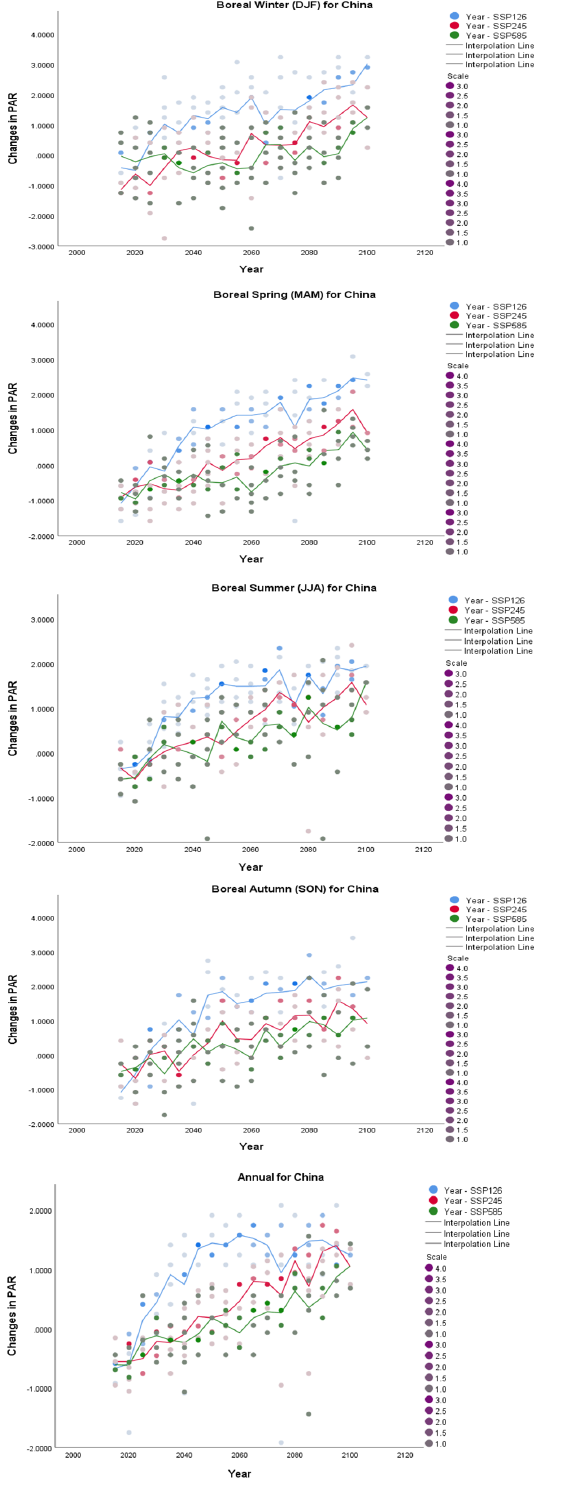
Figure 5. Impacts of climate change (represented by changes in PAR (in percent)) on PAR productivity under various global warming scenarios, seasons, and annual time scales in China (left column) and India (right column).